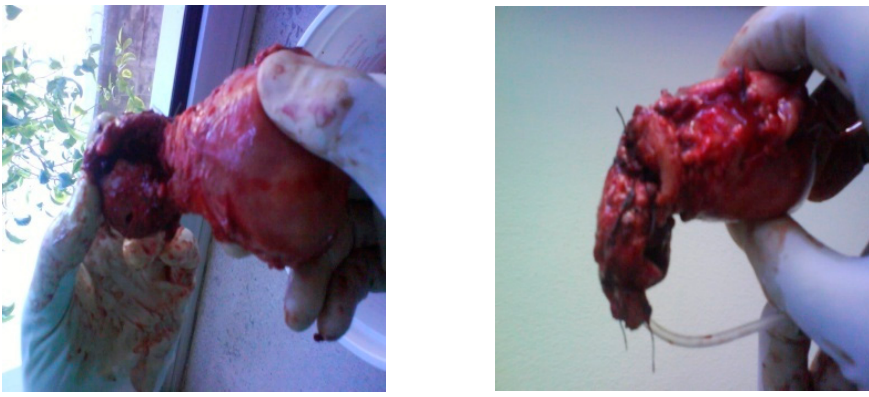
Figure 7. Section of hysterectomy with ectopic pregnancy.